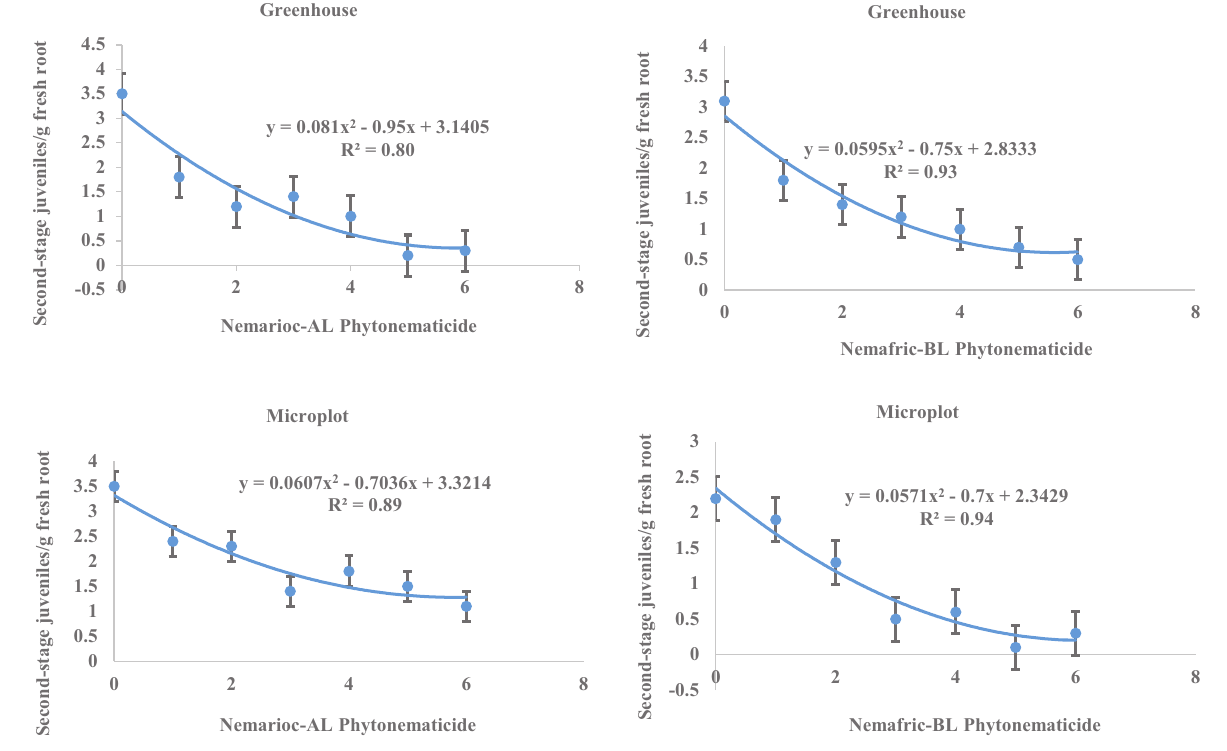
FIGURE 3 | Response of M. incognita second-stage juveniles in roots of pea seeds primed in cucurbitacin phytonematicides and seedlings raised in greenhouse and microplot conditions (Bar represents mean ± standard error) (The x-axis comprised transformed data, where 0 = 0%, 1 = 2%, 2 = 4%, 3 = 8%, 4 = 16%, 5 = 32%, and 6 = 64%